Question: Briefly state, in one sentence, what is plotted here.
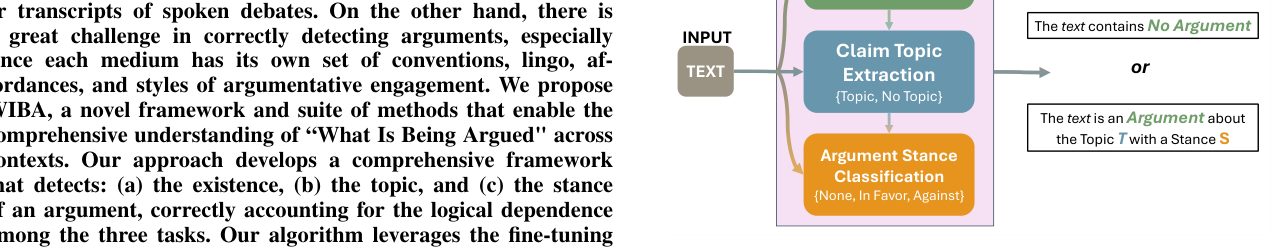
Answer: This figure illustrates the proposed task and methods. The process begins with a given text input, where the first step is to determine the presence of an argument. If an argument exists, the subsequent steps involve extracting the topic being argued, and classifying the stance towards that topic. While each method can operate independently, out of order, Argument Stance Classification requires that a specific topic be provided along with the text.